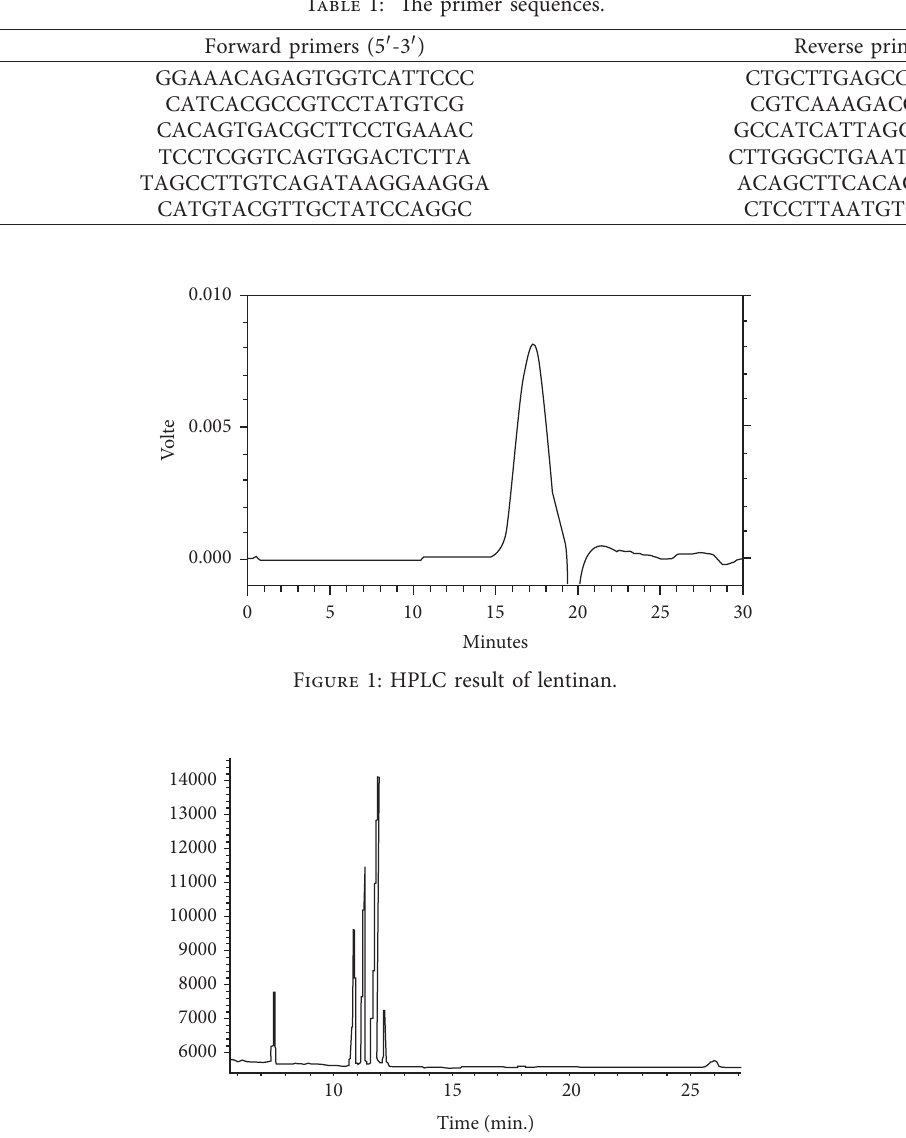
Figure 2: Gas chromatogram of